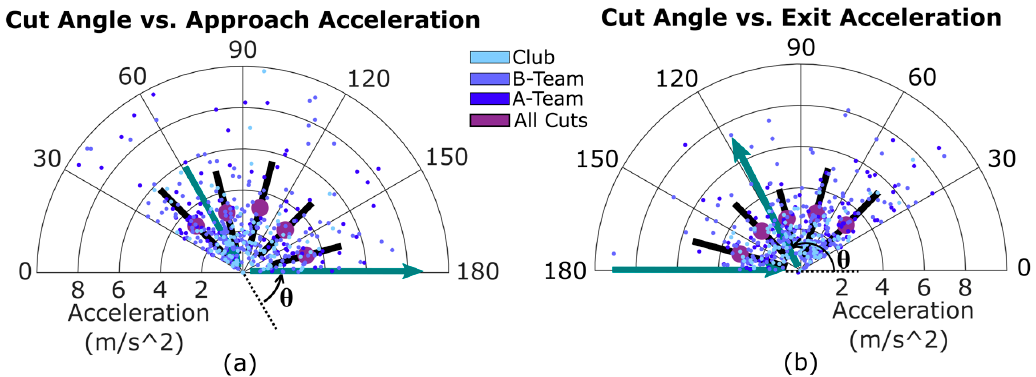
Figure 5. Approach ( a ) and exit ( b ) accelerations for different cut angle ranges (in degrees). The purple dot shows the average speed for each cut angle range, while the black line shows standard deviation. Though approach acceleration values are all negative, they are shown on the left as positive. Accelerations from the three teams are shown in different colors and an example path of a player through a cut is shown in green arrows. The polar axes are restricted to better show trends; 13 outlier accelerations are outside this view.